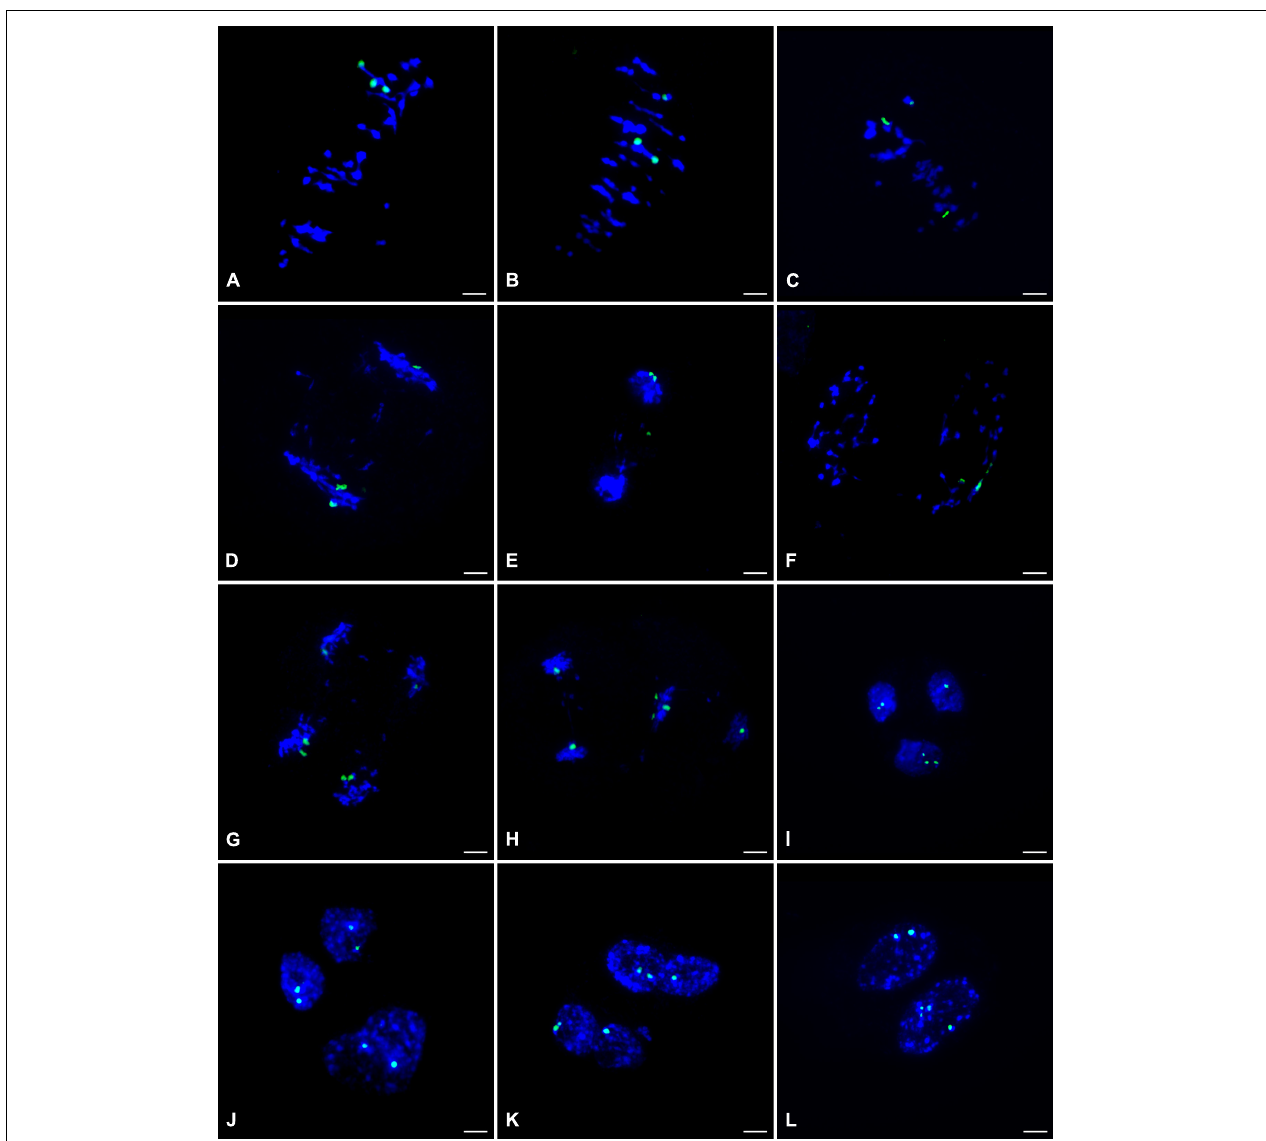
FIGURE 4 | 45S rDNA– fluorescence in situ hybridization (FISH) analysis during the meiosis of the male parent ‘Yinzhong’. (A) Metaphase I cell showing one trivalent with 45S rDNA signals (green). (B) Metaphase I cell showing a bivalent and a univalent with 45S rDNA signals. (C) Metaphase I cell showing three univalents with 45S rDNA signals. (D) Anaphase I cell showing imbalance 45S rDNA-located chromosome segregation. (E) Anaphase I cell showing one 45S rDNA signal on a lagging chromosome. (F) Telophase I cell showing all 45S rDNA signals in one daughter nucleus, (G) Anaphase II cell with normal meiotic 45S rDNA-located sister chromatid segregation. (H) Anaphase II cell showing three 45S rDNA signals in one chromosome group. (I) Two normal daughter nuclei at telophase II including one and two 45S rDNA signals, respectively, and one fused nucleus including three signals. (J) Two normal daughter nuclei and one fused nucleus at telophase II including two 45S rDNA signals, respectively. (K) Telophase II with two fused nuclei including three 45S rDNA signals, respectively. (L) Telophase II with two fused nuclei including two and four 45S rDNA signals,